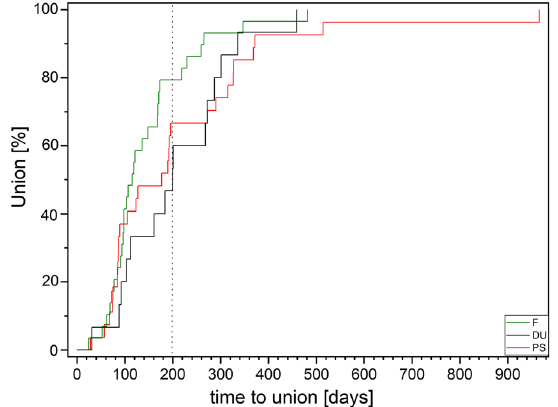
Fig. 8 Kaplan–Meier curve for time to union: only patients with unions are included. Patients are divided into those with a fresh fracture (time between injury and surgery was < 3 weeks, F), delayed union (time between injury and surgery was between 3 weeks and 6 months, DU) and pseudarthrosis (time between injury and surgery was > 6 months, PS). The vertical dotted line is included to facilitate reading the figure at 200